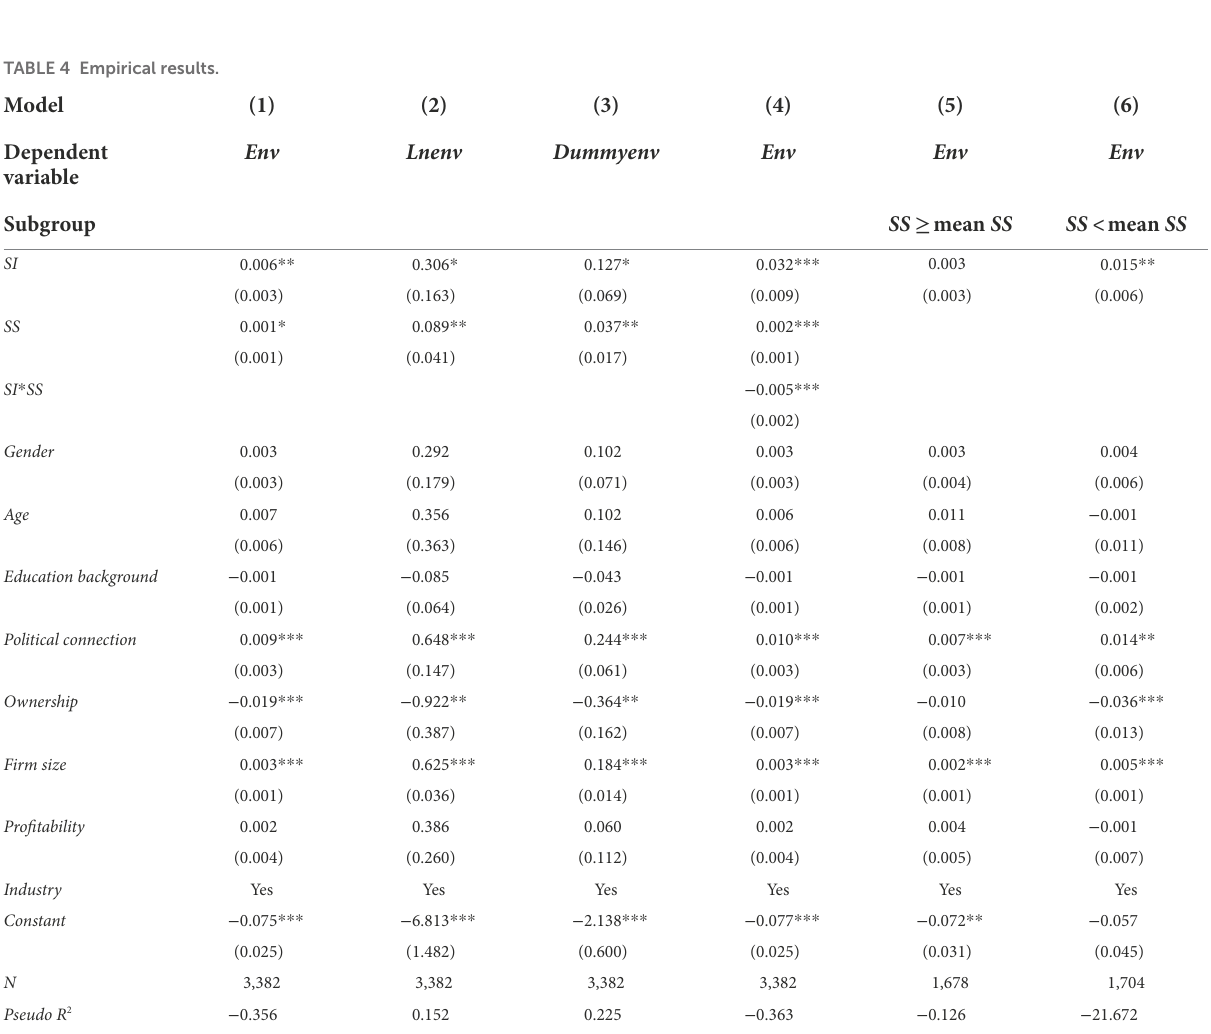
TABLE 4 Empirical